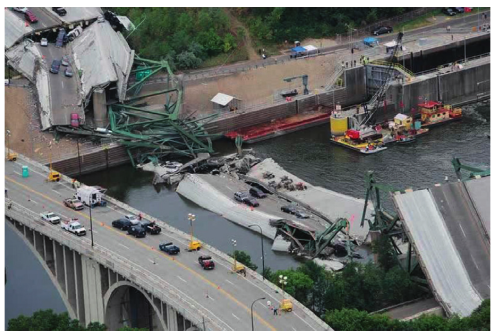
Figure 2: Collapse of the I-35W Highway Bridge